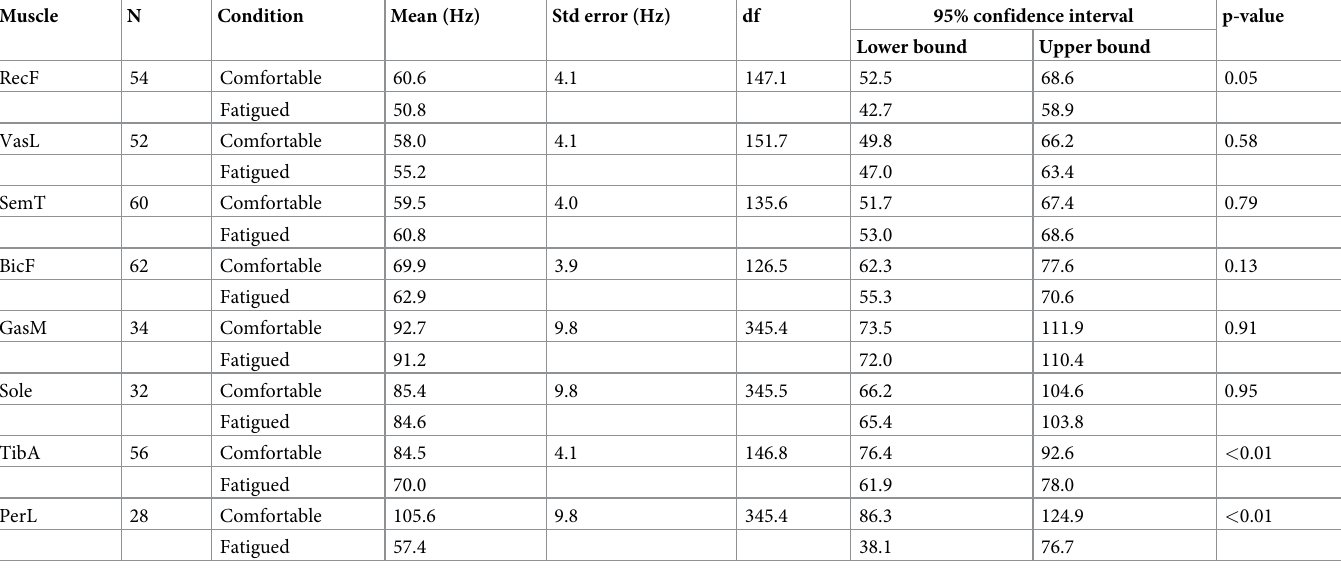
Table 3. Estimated marginal means of the MF per muscle, based on the linear mixed-effects model.